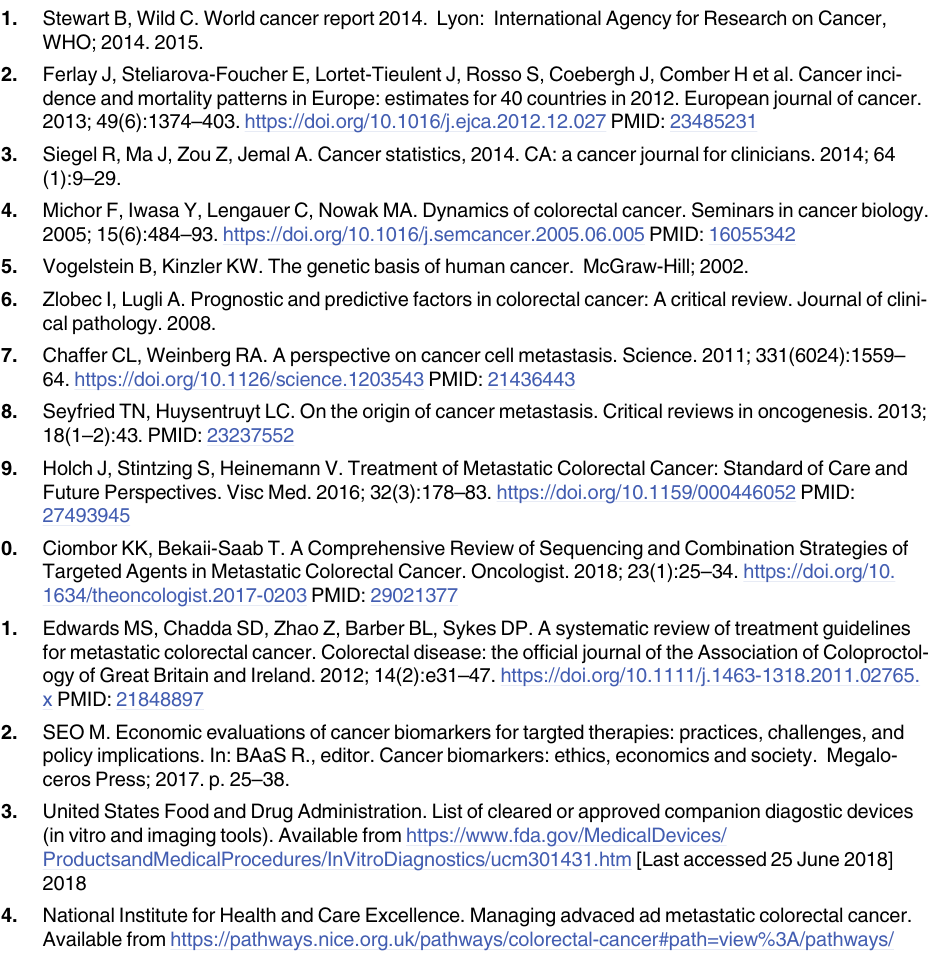
S6 Table. QHES scoring per